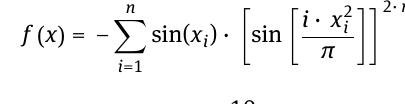
Fig. 1: Ackley’s Path function response for a 2-variable case.